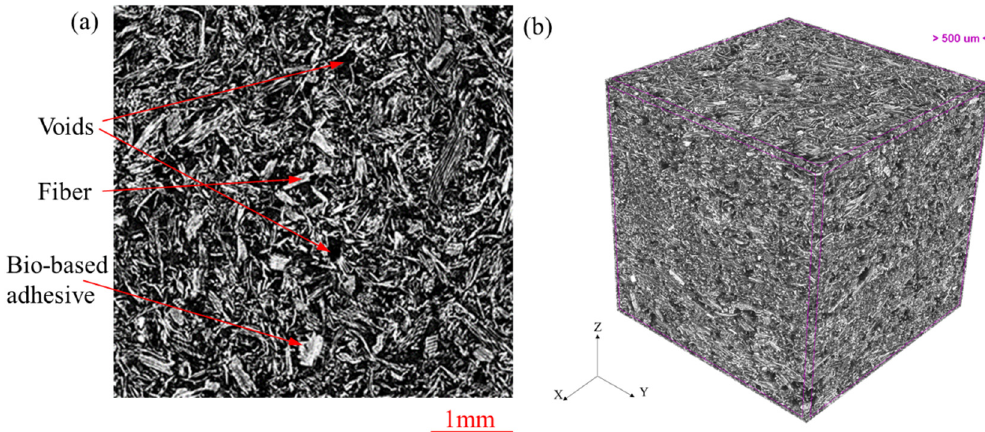
Figure 8. Micro-CT micrographs of wood fiber insulation board. ( a ) Identification of wood fibers, bio-based adhesive, and voids from insulation board. ( b ) A 3D model of volume of 5 mm × 5 mm × 5 mm of insulation boards.